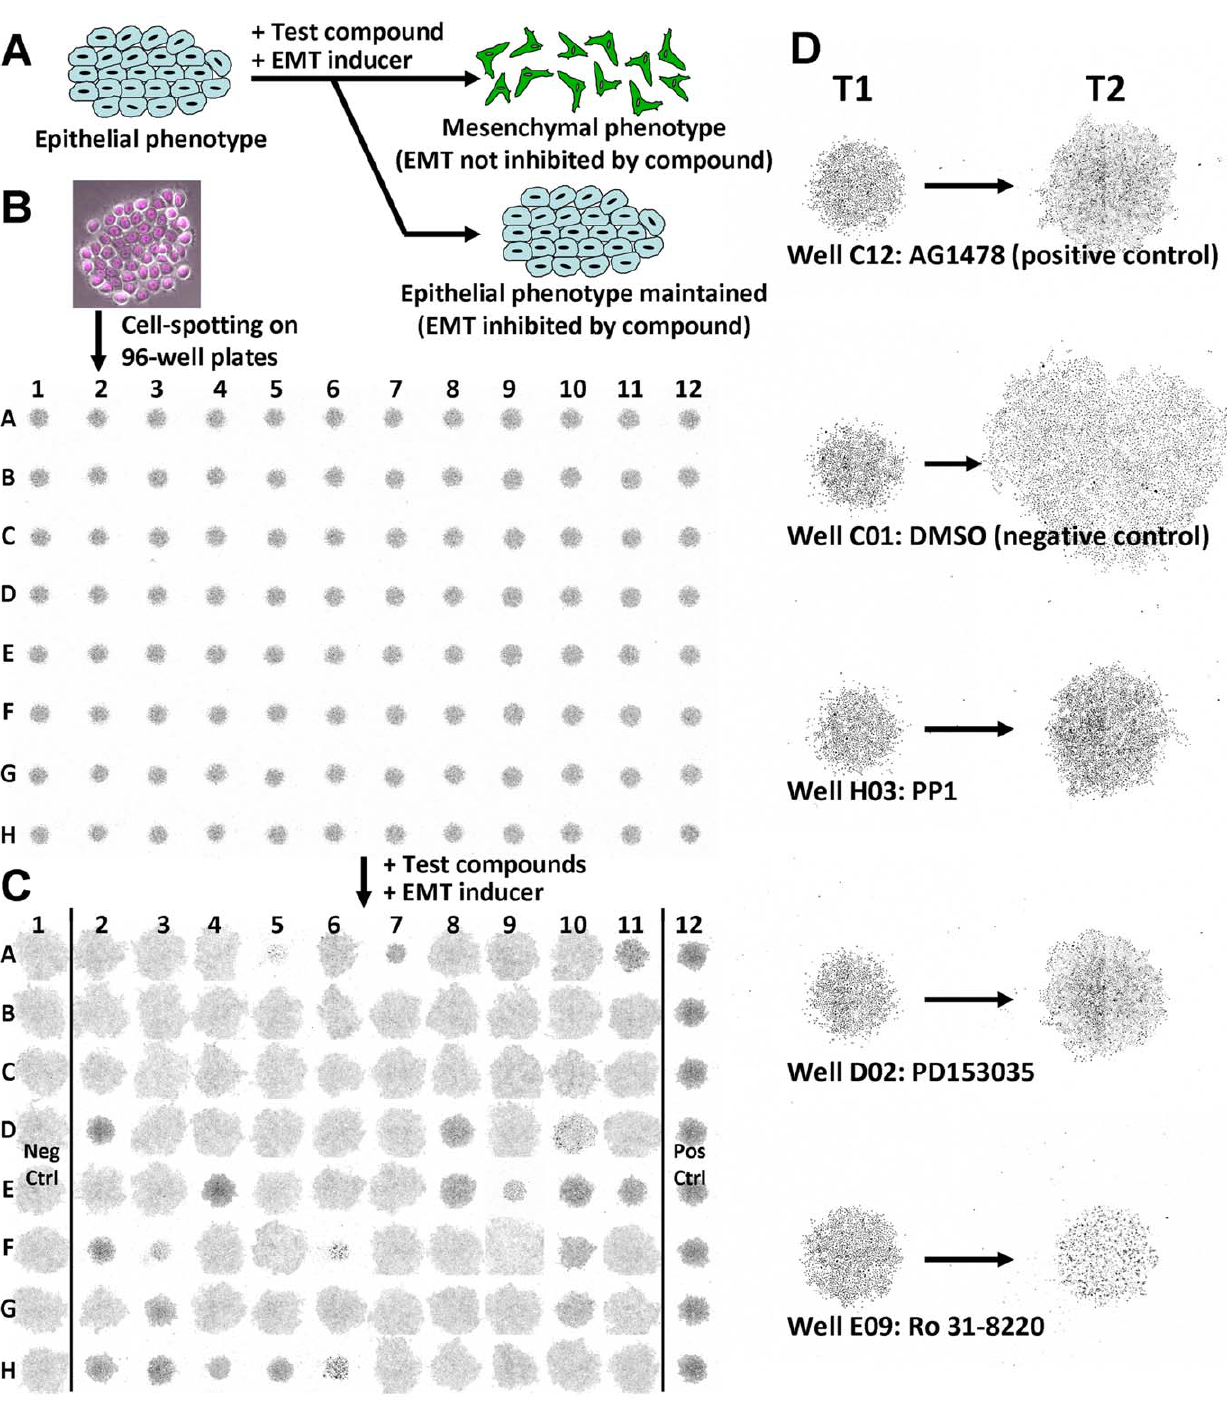
Figure 1. EMT spot migration screening assay overview. (A) Schematic of the spot migration screening assay to identify EMT inhibitory compounds. EMT can be initiated and maintained in epithelial cells via growth factor signaling. This assay measures the dispersion of cells in the presence of a test compound and an EMT inducer (EGF, HGF or IGF-1). The prevention of cell dispersion directly correlates to the propensity of a test compound to block an induced EMT signaling pathway. (B) Screening assay image acquisition workflow. Robot-assisted plating of H2B-mcherry transfected NBT-II cells into the well centers of 96-well plates. The initial plate image acquired at T1 served as the baseline reference for calculating the CCR and CDR values for each well. The cells were treated with test compounds overnight and further incubated for 24 h with a growth factor to induce EMT. (C) Final plate image acquired at T2 depicted the dispersion response of cells 24 h after addition of the compounds and growth factor treatment. In the example shown, columns 2–11 were treated with 80 different test compounds at 6.67 m M and EGF. Column-1 served as negative controls treated with 0.67% DMSO and EGF, while column-12 served as positive controls treated with 6.67 m M AG1478 and EGF. (D) Magnified images of selected wells acquired at T1 and T2. Wells C12, H03 and D02 are examples of cell colonies treated by compounds that inhibited EGF-initiated cell dispersion and did not inhibit cell growth. Well C01 is a cell colony undergoing EGF-induced EMT without any dispersion inhibition. Well E09 is a cell colony treated by a growth inhibitory or toxic compound. doi:10.1371/journal.pone.0033183.g001 PLoS ONE |